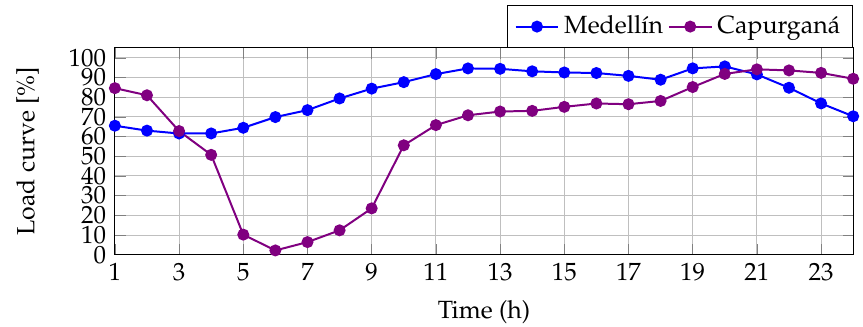
Figure 6. Expected average demand curve for Medellín and Capurganá, Colombia.